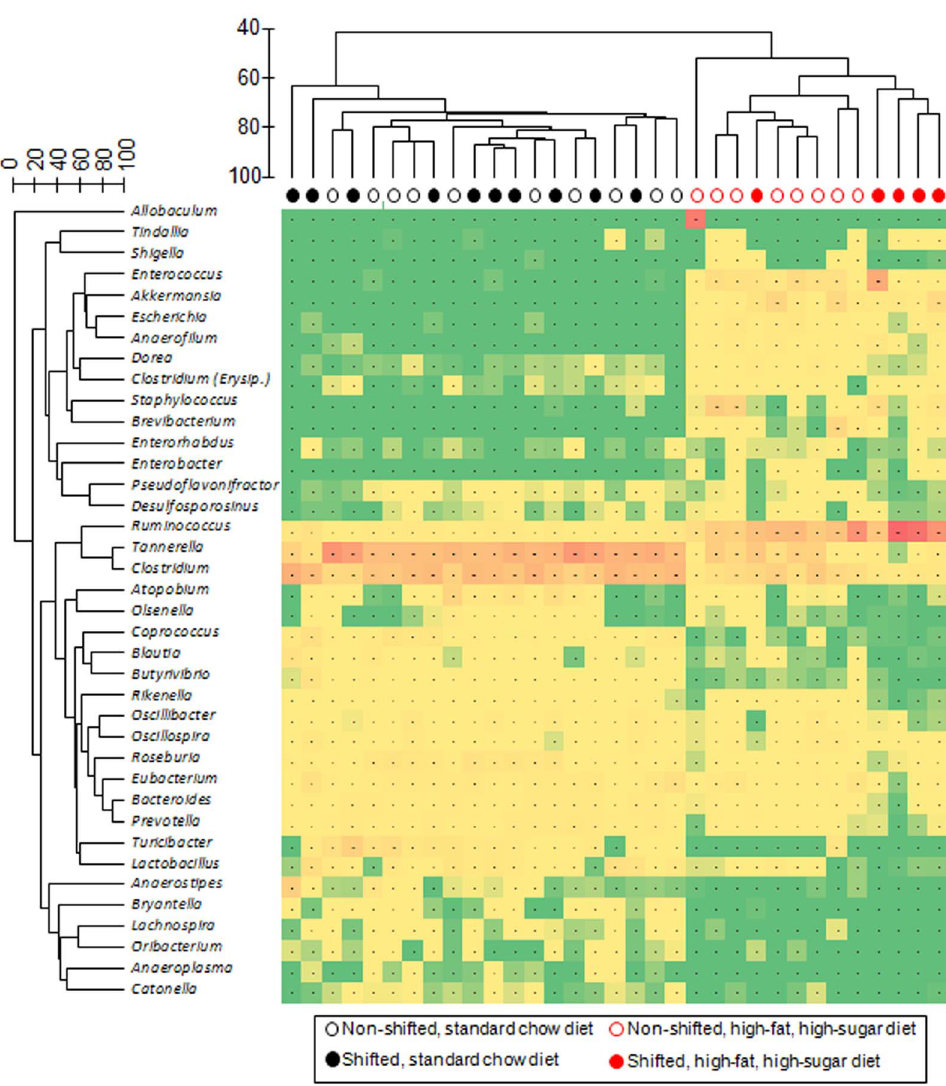
Figure 8. Genus-level gut microbial community analysis. A dual hierarchical dendogram describes the 40 most abundant genera detected in the amplicon sequence study (y-axis) across the mouse fecal samples. The heat map indicates the relative abundance of sequences derived from bacteria belonging to each genus, scaled to each sample (red=most abundant; green=no sequences) (x-axis). The clustering of samples was performed on the full dataset of sequences, and sequence data abundance values were standardized by sample, square-root transformed, and a resemblance matrix was generated using Bray-Curtis similarity. Similarly, hierarchical clustering was performed on the 40 most abundant species, using standardized abundance data and Bray-Curtis similarity. Group average hierarchical clustering was performed on both